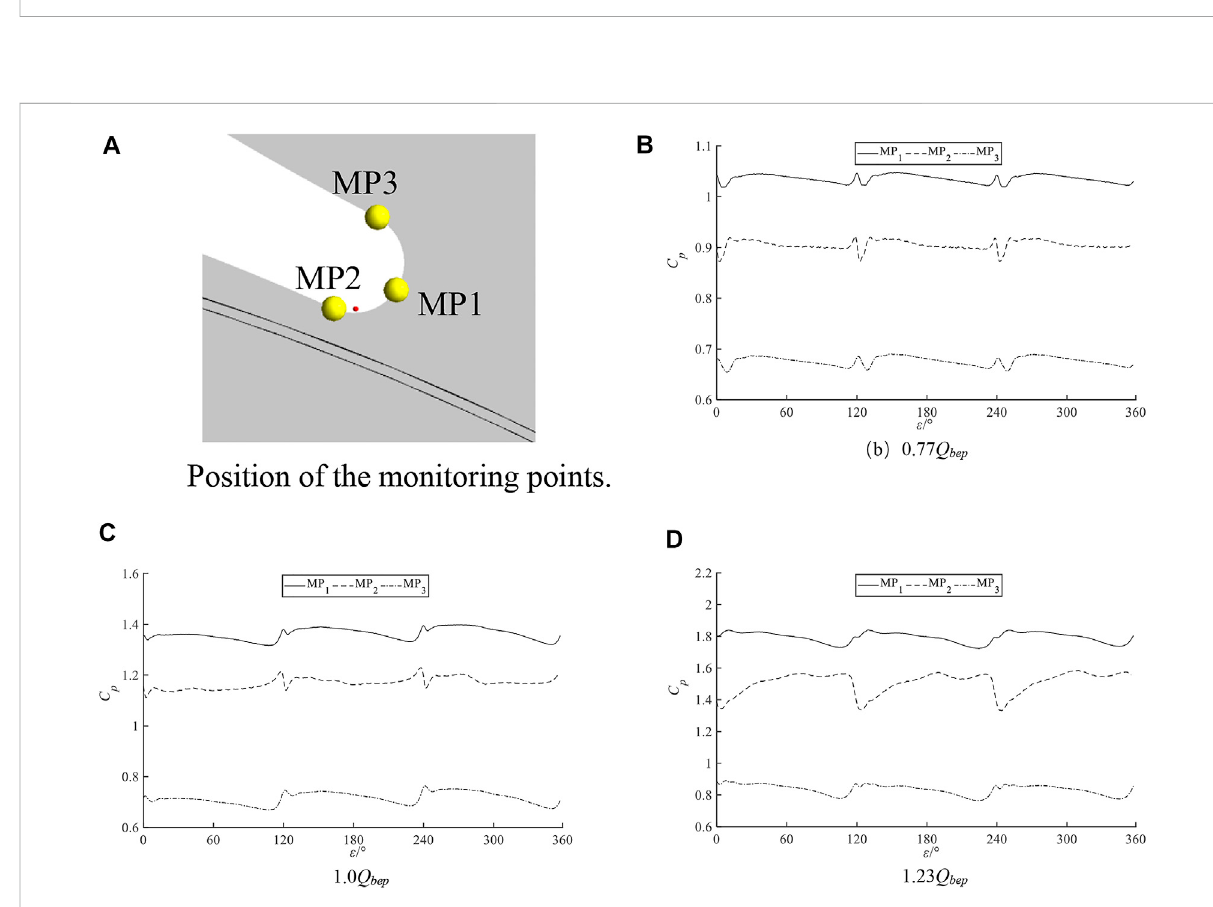
FIGURE 10 Variation of pressure coef fi cient at monitoring points. (A) : Position of the monitoring points; (B) : 0.77 Qbep; (C) :1.0 Qbep; (D) : 1.23